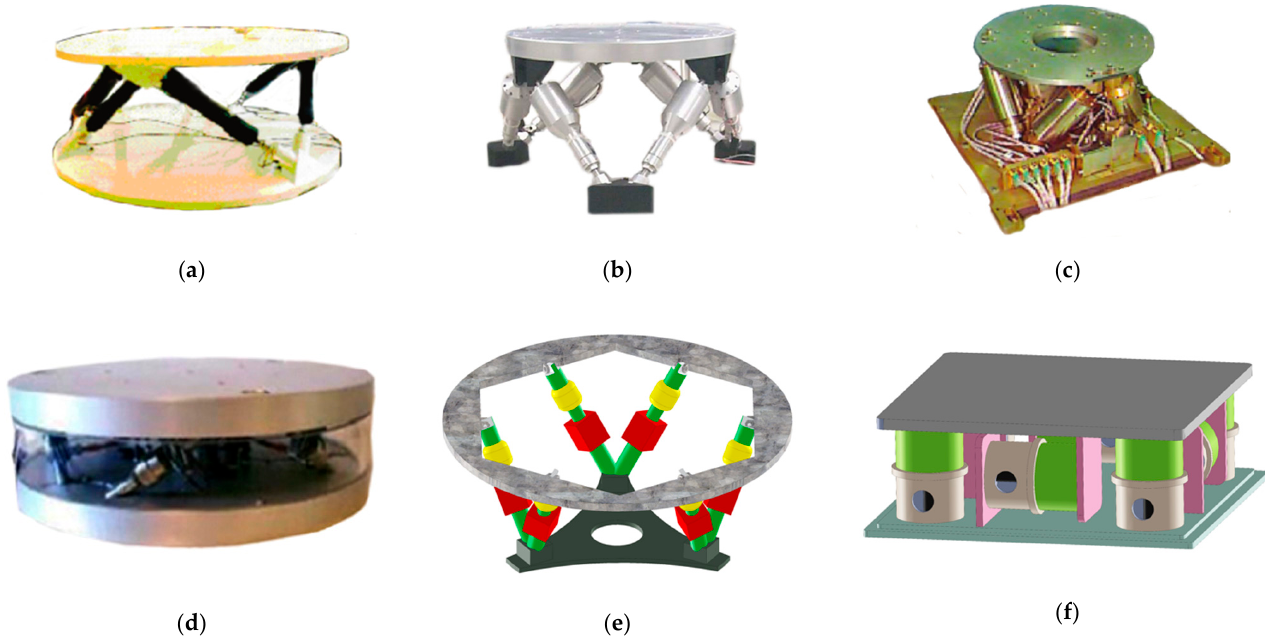
Figure 13. The schematic diagram of the typical rigid Stewart platform: ( a ) HAVI rigid Stewart platform; ( b ) UQP rigid Stewart platform; ( c ) SUITE rigid Stewart platform; ( d ) ULB rigid Stewart platform; ( e ) PH1 rigid Stewart platform; ( f ) GMS/air rigid Stewart platform.